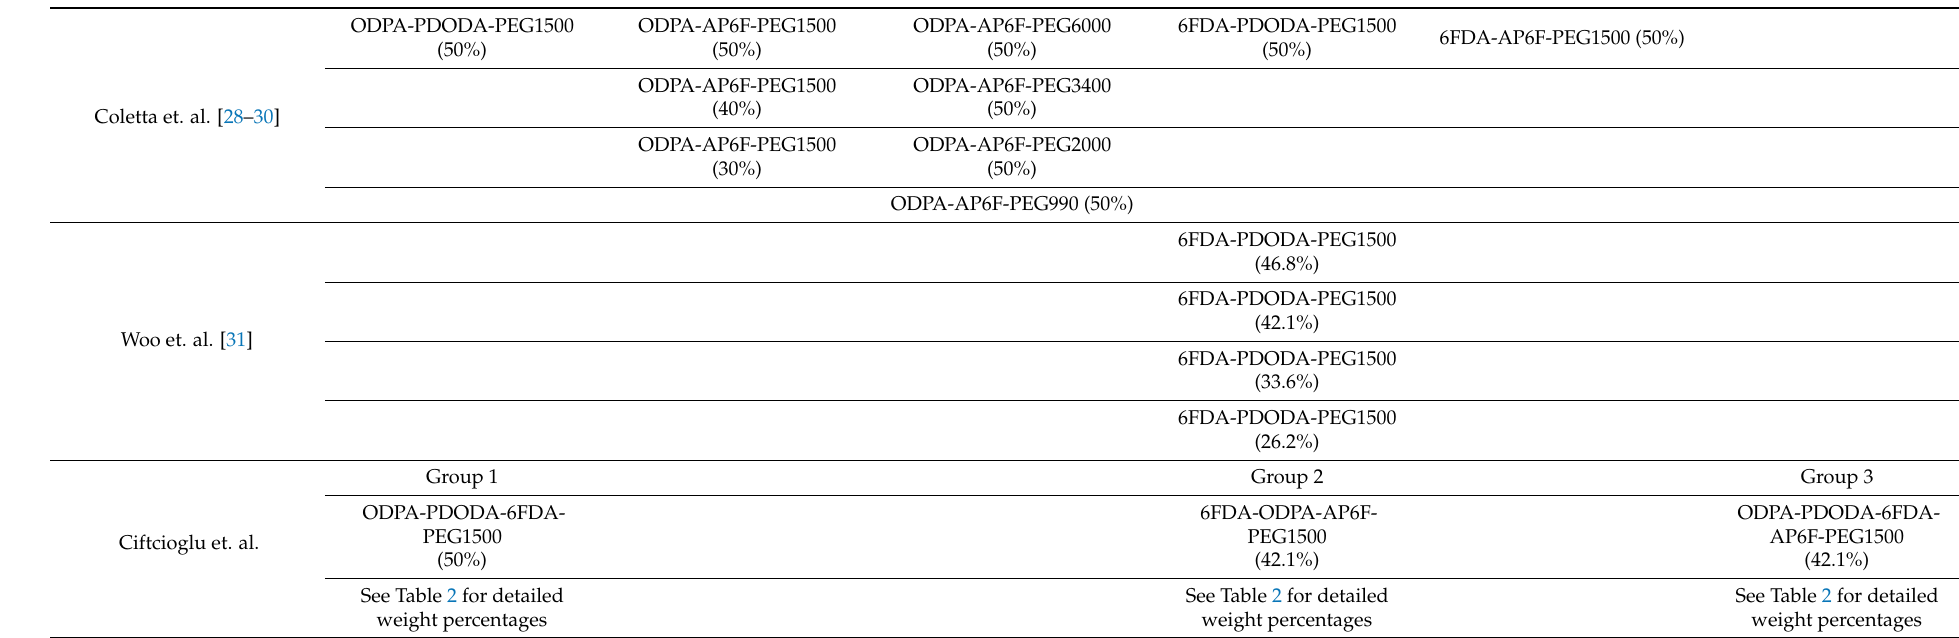
Table 1. Comparison of polyimide-poly(ethylene glycol) segmented block copolymer (PI-PEG SBC) membranes synthesized previously by Coletta et al. [28–30] and Woo et al. [31] with the membranes synthesized in this